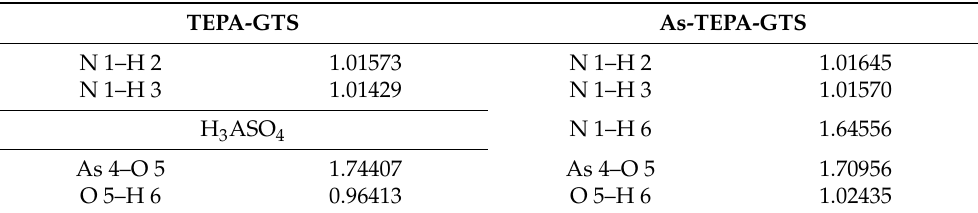
Figure 10. Optimized structure of ( a ) TEPA-GTS; ( b ) H3AsO4; ( c ) As-TEPA-GTS. Table 5. Selected structural parameter of optimized geometries on bond length.